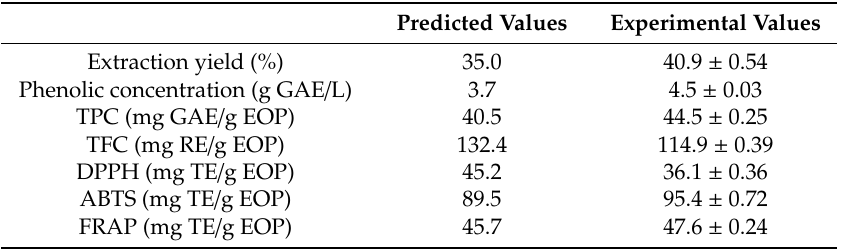
Table 5. Real and predicted values by the mathematical model for the